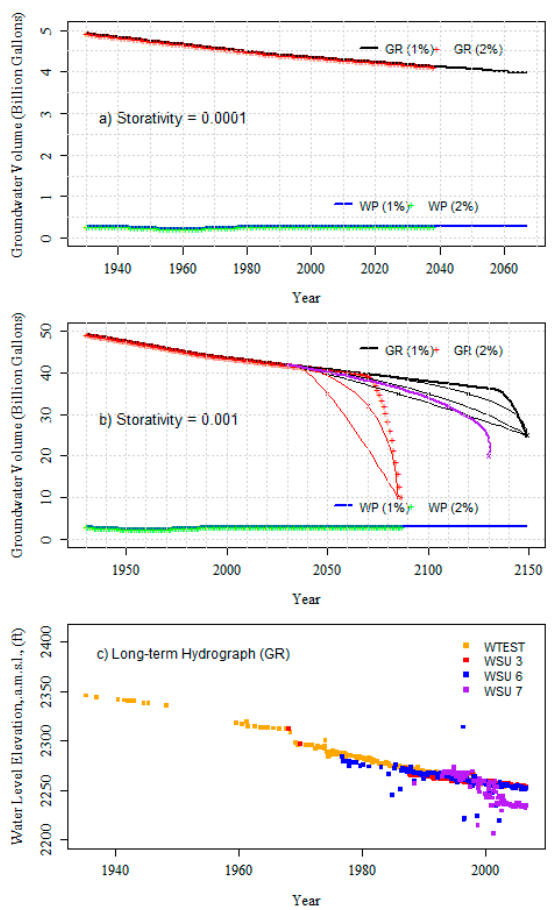
Figure 4. Simulation results of volume of water in ( a ) Wanapum and Grand Ronde ( billion gallons—storativity − 0.0001) ( b ) curve fitting of drawdown (black for 1% growth, red for 2% growth and purple for some hypothetical midway between 1% and 2%—storativity − 0.001) ( c ) obseved long-term GR hydrograph at Washington State University (WSU) GR Wells (above mean seal level (a.m.s.l.)).